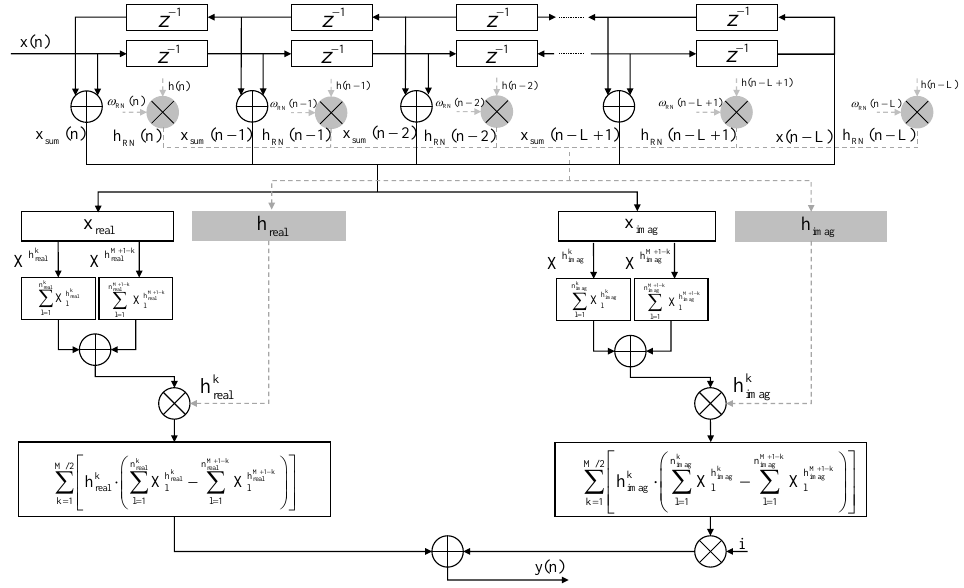
Figure 3. Symmetric CQWO-TD-CDE FIR filter